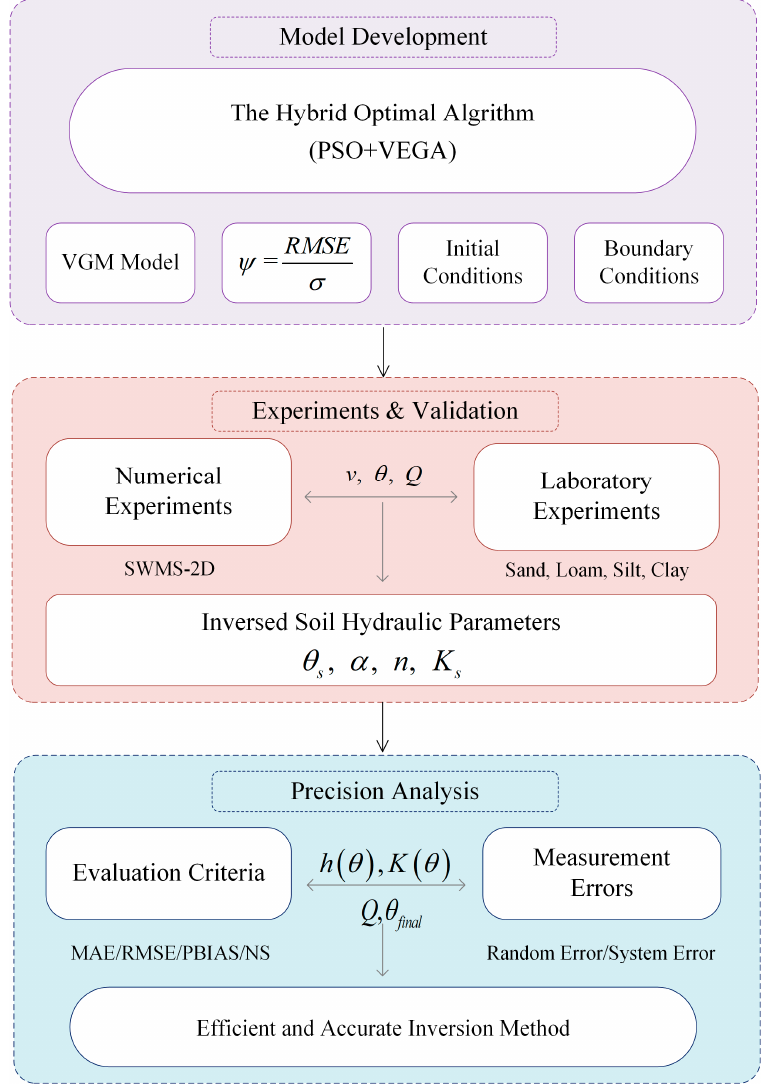
Figure 1. A flowchart overview of the research process.